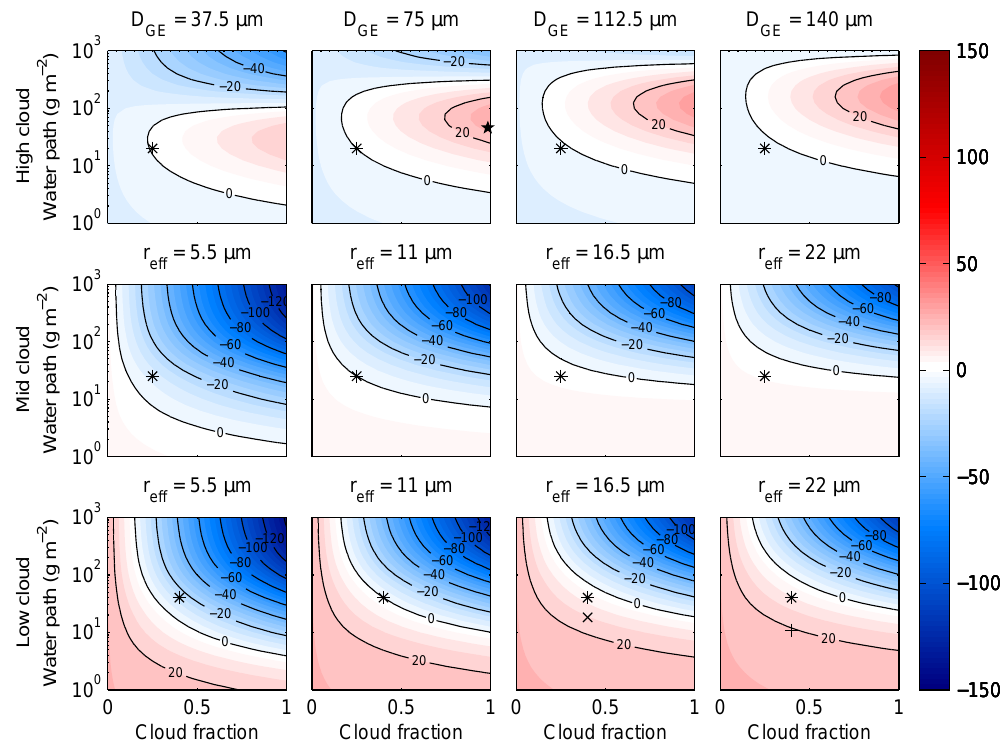
Fig. 12. Change in net cloud radiative forcing with cloud particle size, across a range of cloud fractions and water paths. Particle size is varied for each layer independently (values in subplot titles), whilst all properties for other cloud layers remain as case study. The change is shown relative to the case study (so panels for r eff =11µm and D GE =75µm contain the same information as Fig. 11 net fluxes). Cloud fraction and water path for case study are marked ( S ); values at the point of these markers are for changing particle size only, values elsewhere in each panel are for changing water path or fraction too. Markers ( × ) and (+) refer to reduction in water path by factors of 2.2 and 3.7, respectively, for comparison to Rosing et al. (2010), as discussed in the text. Marker ( S ) corresponds to the relatively thick and maximum extent clouds invoked by Rondanelli and Lindzen (2010). Colour/contour scale is in Wm − 2